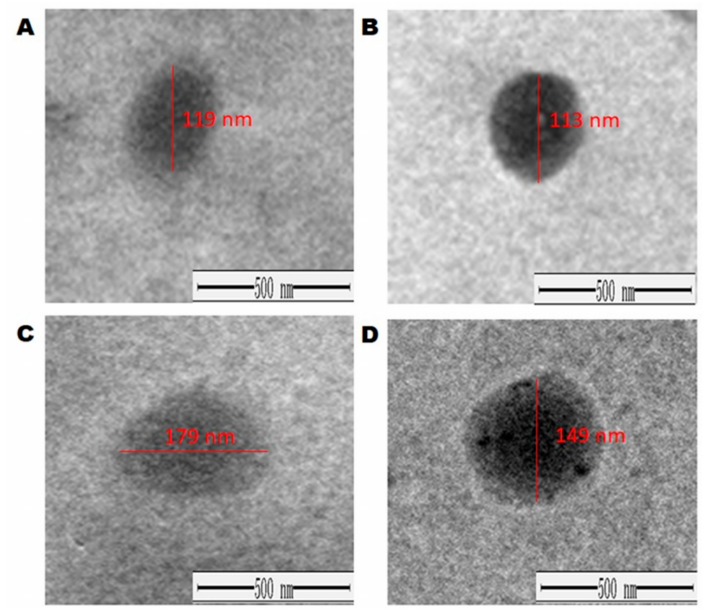
Figure 4. Morphological changes in liposomes before and after loading of drugs under TEM ( A ) Empty liposome (EL), ( B ) DOX loaded liposome (DXL), ( C ) OA loaded liposome (OAL), and ( D ) OA and DOX loaded/combined liposome (ODL).